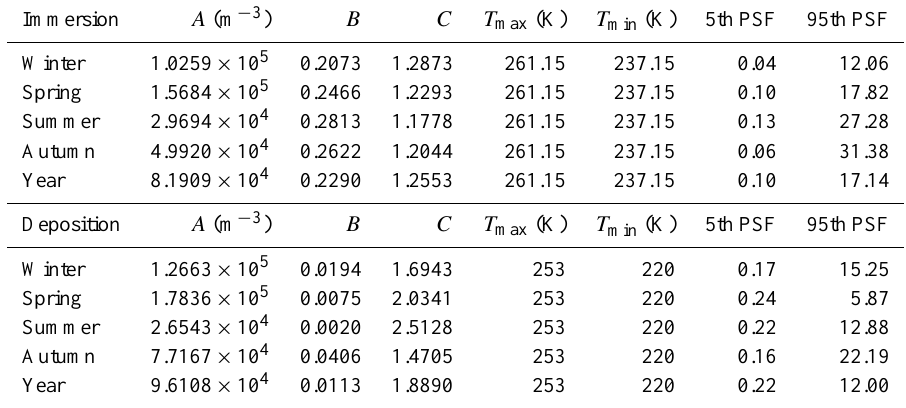
Table 1. Parameters defining Eq. (1), for immersion and deposition INP concentrations (at RH ice = 110%). The percentile scaling factors (PSF) for the 5th and 95th percentiles are